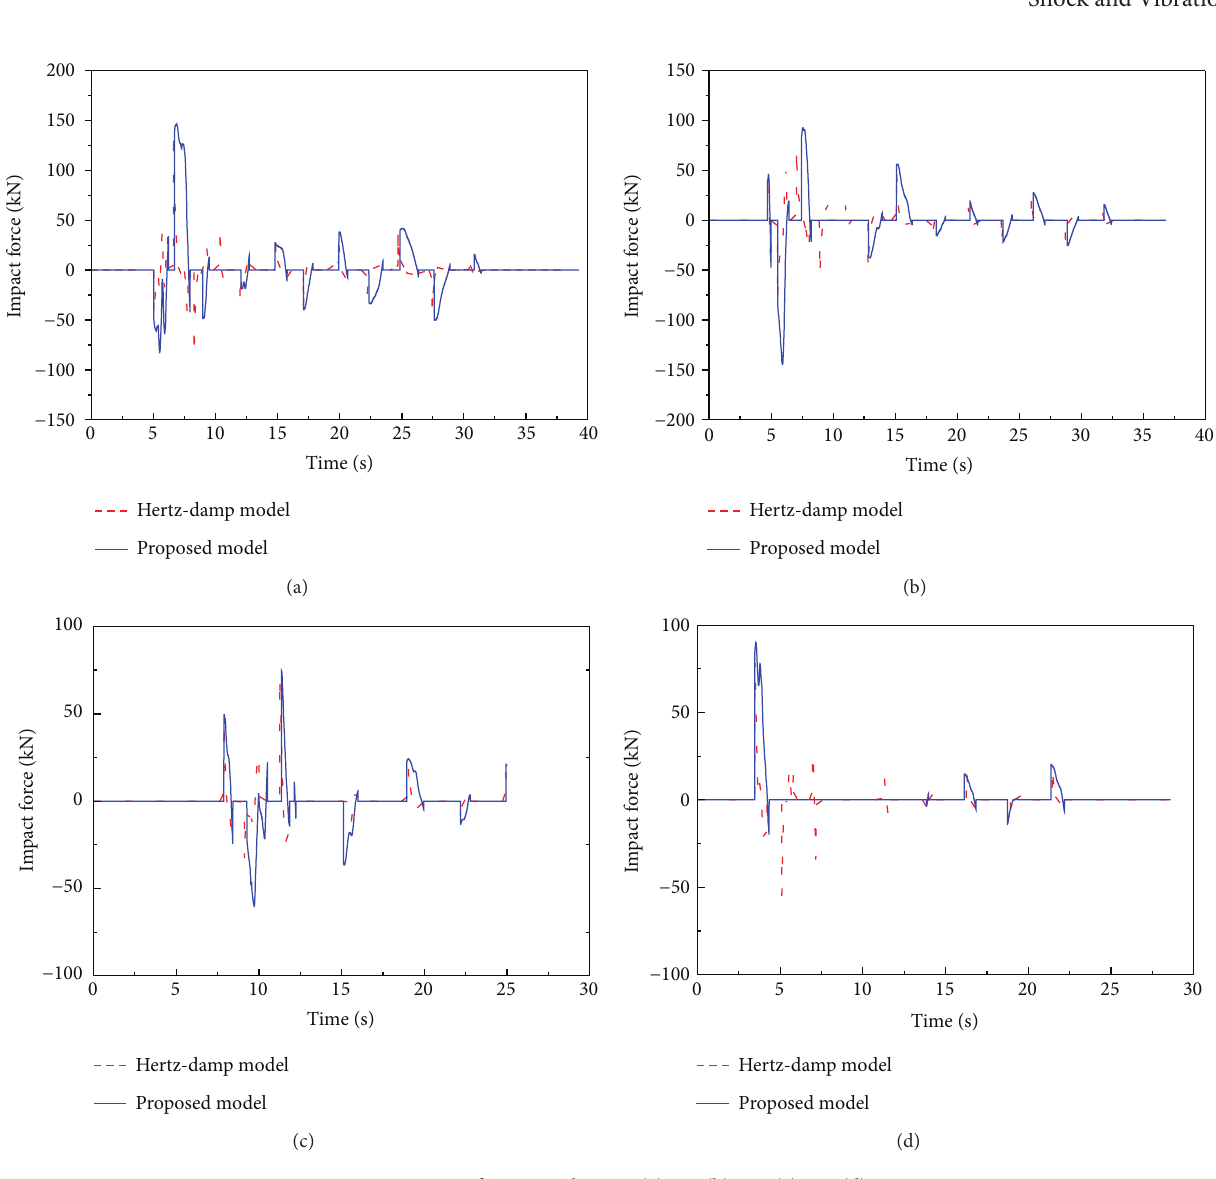
Figure 9: Impact force time history (a) N1; (b) N2; (c) N3; (d)